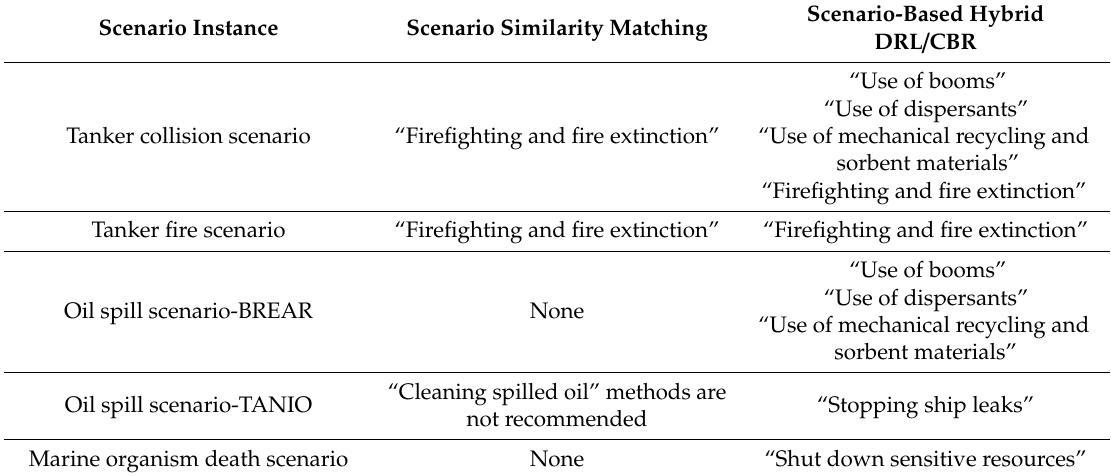
Table 5. Comparison of the two methods in typical oil spill emergency response action